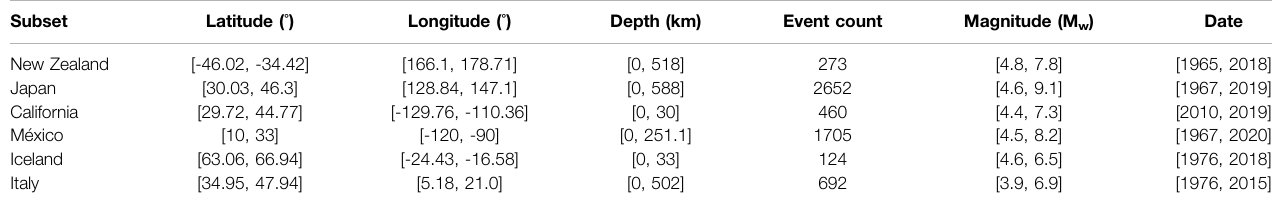
TABLE 1 | Filters applied to the GCMT database to extract six regional datasets. We list the total amount of events in each dataset. Databases have been queried from IRIS “ https://ds.iris.edu/spud/momenttensor ” Subset